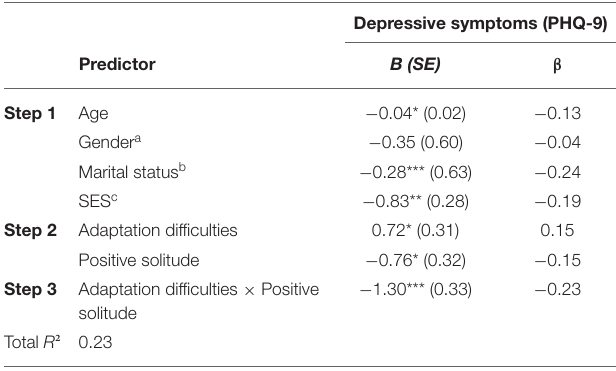
TABLE 3 | Regression coefficients for the association between return-to-routine adaptation difficulties, positive solitude and depressive symptoms. Depressive symptoms (PHQ-9)